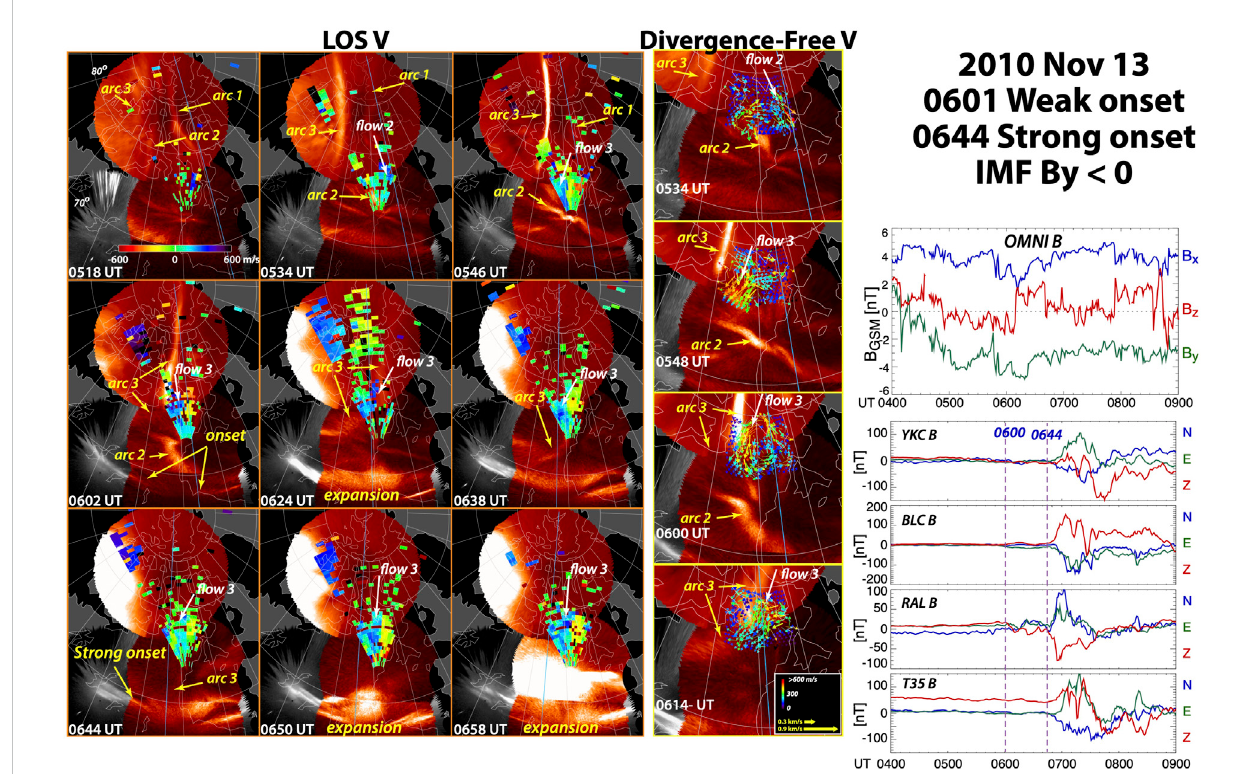
FIGURE 2 Selected mosaics of images for 0518 – 0614 UT on 13 November 2010 as in Figure 1. Supplementary Movie S3 shows a movie of the mosaics every 2 min over the full-time interval of interest displaying more of the THEMIS ASI imagers FOVs than in Figure 2. Overlaid on the mosaics are LOS fl ows obtained from all available SuperDARN radar echoes. Images with two-dimensional fl ows are shown in the column to the right of the images with LOS fl ows for times when the two-dimensional fl ow was of suf fi cient quality to discern a fl ow channel and its relation to a polar cap arc. The IMF from NASA OMNIWeb and ground magnetometer measurements in the vicinity of the auroral disturbance are shown along the right side of the fi